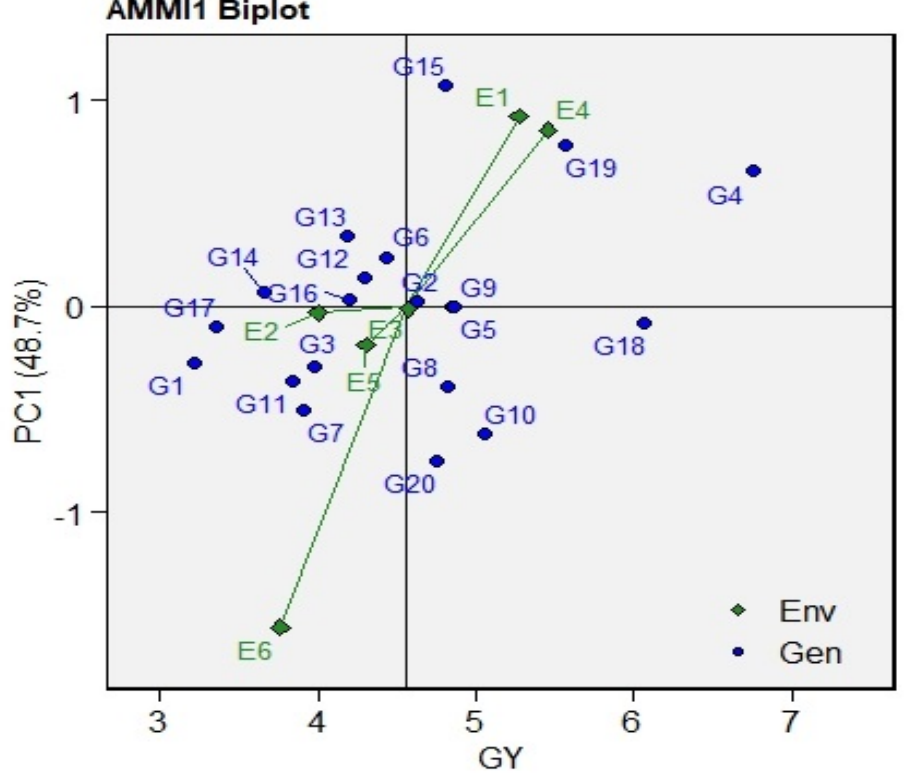
Figure 3. AMMI1 Biplot (mean grain yield vs. IPC1) for grain yield (t/ha) of 20 wheat genotypes and six environments. The genotype (G) code was indicated according to Table 6.